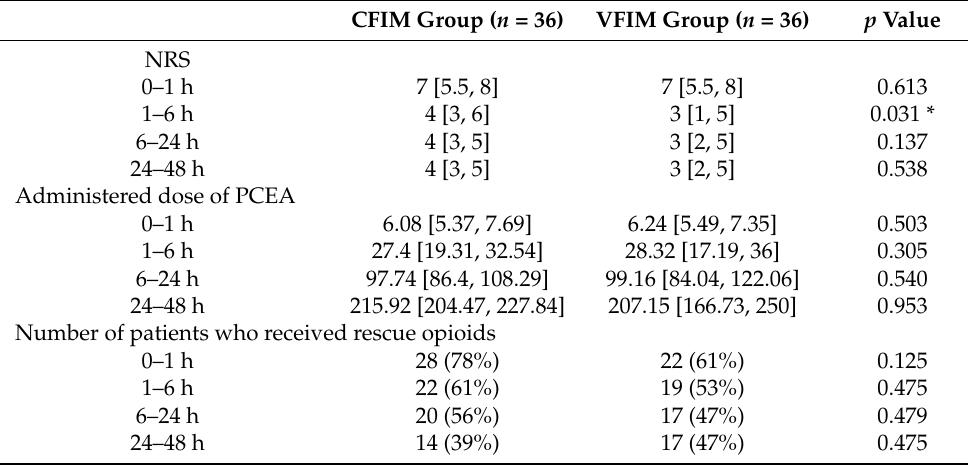
Table 2. Postoperative pain-related profile up to 48 h after